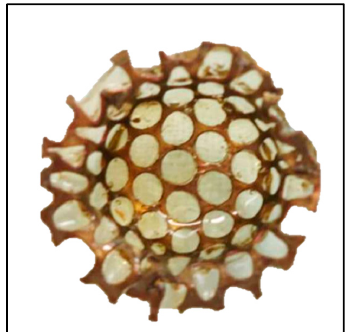
Figure 1. Titanium mesh dome shaped with a 10 mm diameter, coated with polymerized natural rubber latex.